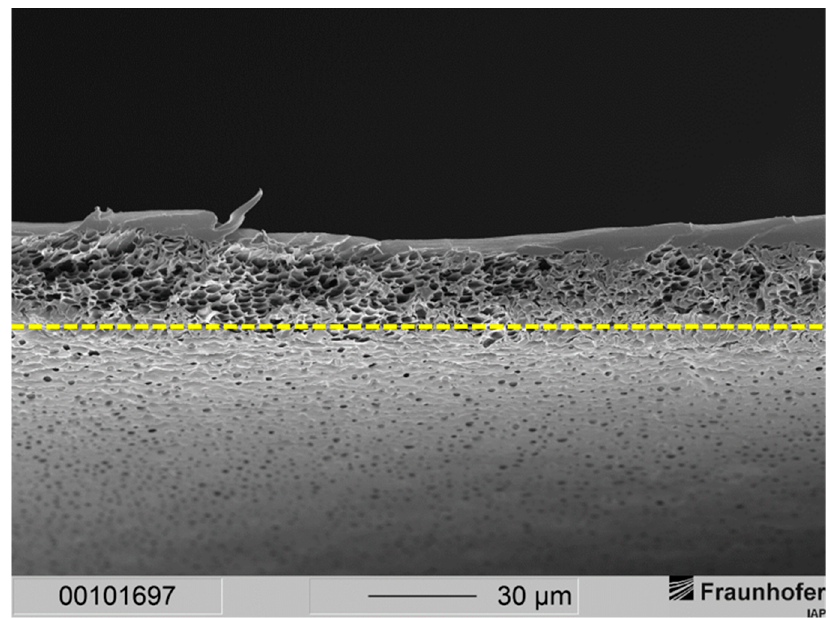
Figure 3. Cross-section of a layered PSU flat sheet membrane cast from a casting solution with 15 wt.-% PSU without PDMS protective layer. The precipitation medium used was distilled water. The dashed line marks the bottom end of the cross-section of the